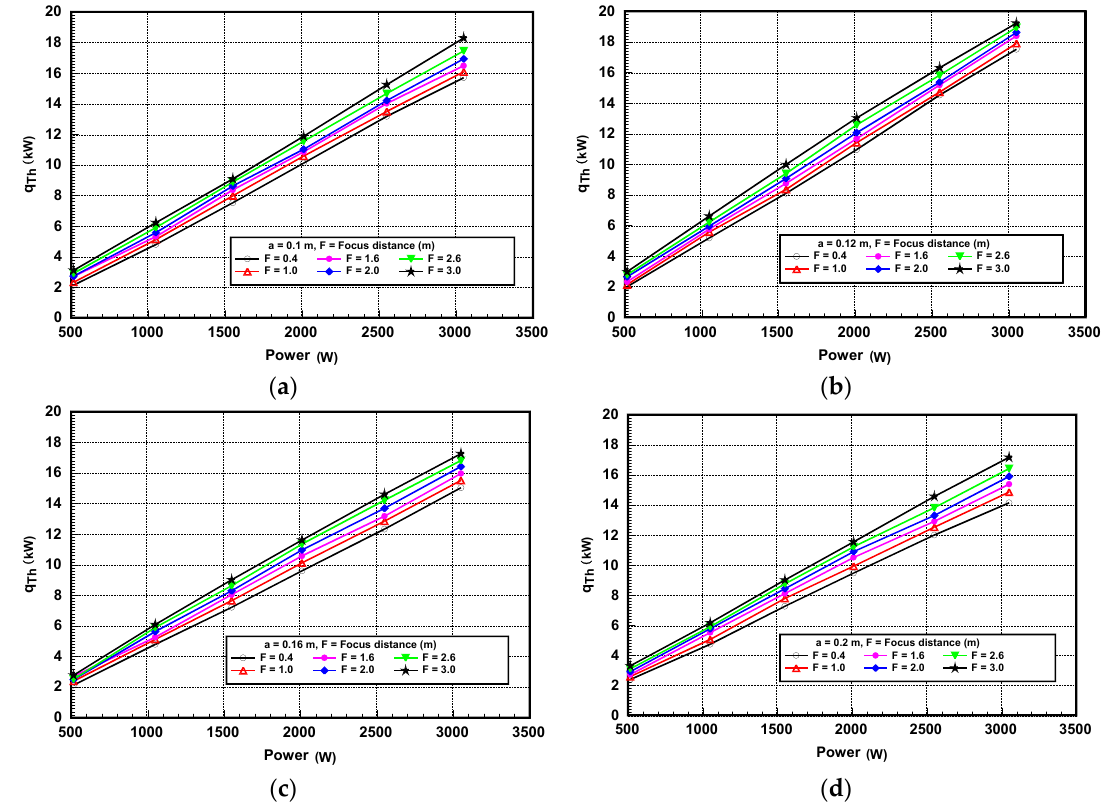
Figure 15. The thermal energy of a CPVT collector plotted against the required power with various focus distance, ( a – d ) different receiver width.